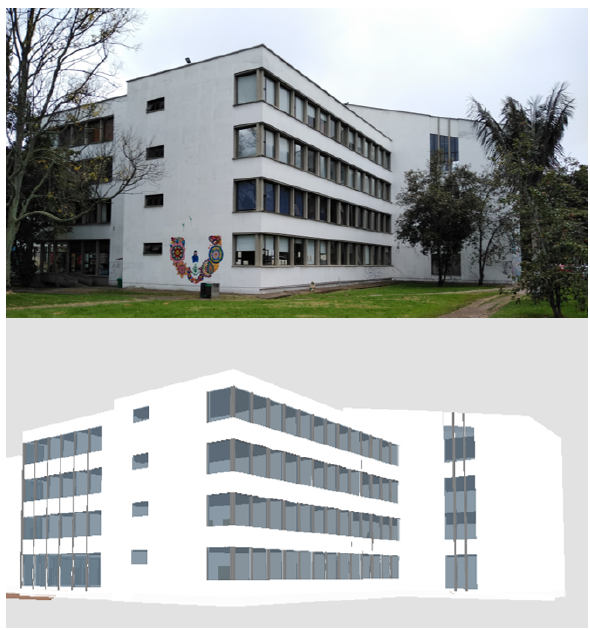
Figure 6. South-West side of the building